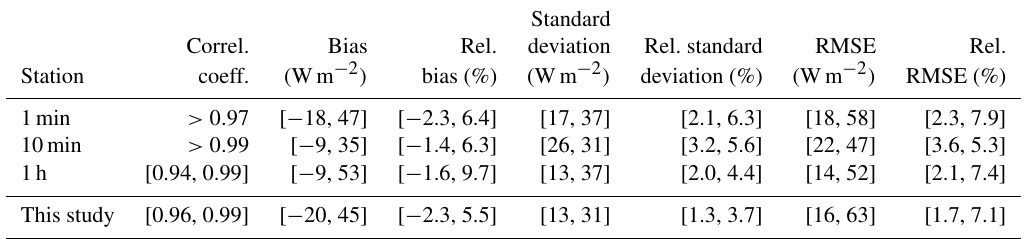
Table 18. Ranges of correlation coefficients, bias, standard deviations, RMSE, and their values relative to the mean of the measurements for G for summarizations 1min, 10min, and 1h, as well as those of the present study. Standard Correl. Bias Rel. deviation Rel. standard RMSE Rel. Station coeff.